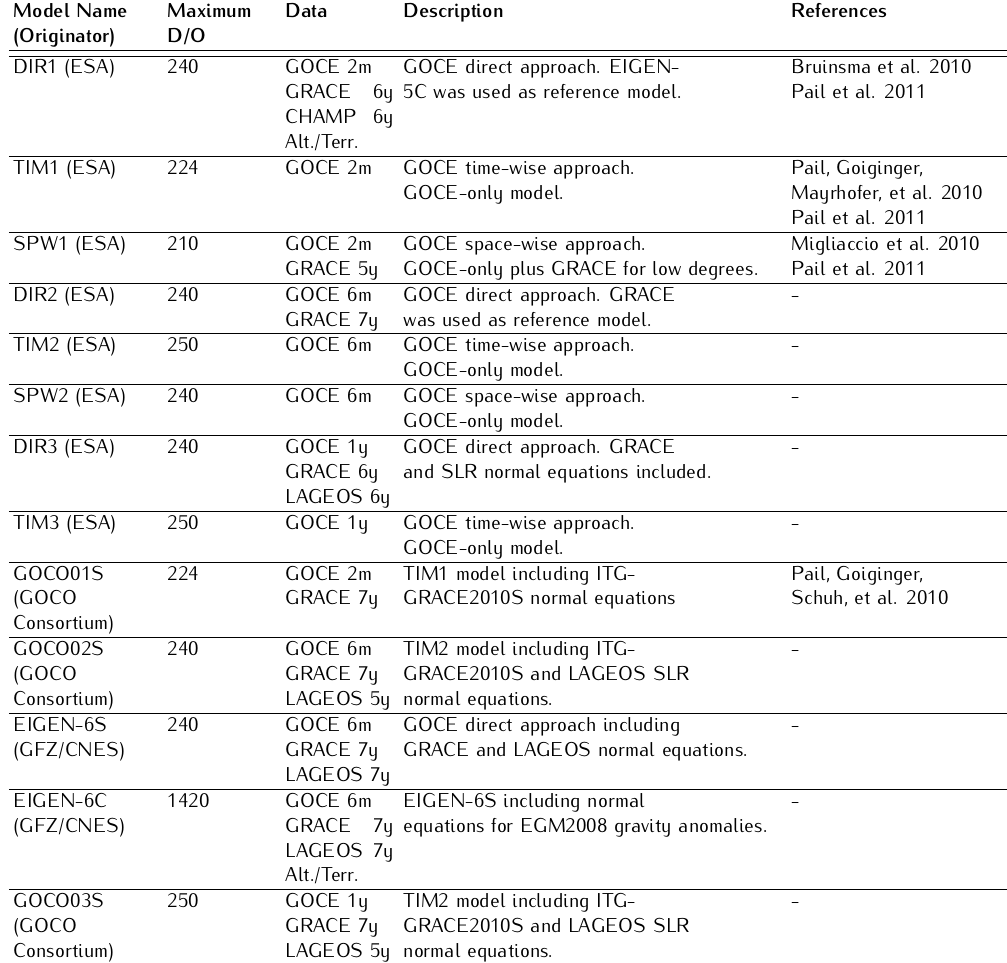
Table 1. Overview of released GOCE based global gravity field models (m = months of data , y = years of data). All models can be accessed via the ICGEM Web Server ( http://icgem.gfz-potsdam.de/ICGEM/ICGEM.html)